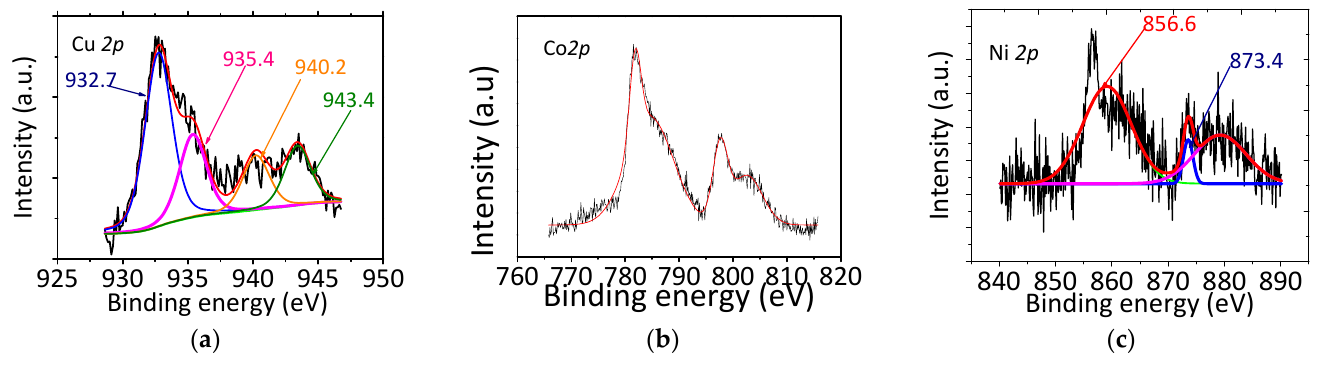
Figure 12. XPS spectra of the Cu 2 p , Ni 2 p , and Co 2 p core levels, respectively, for ( a ) CuCa1H after the 5th cycle, ( b ) CoCu1H after the 3rd cycle, and ( c ) NiCa1H after 6 h of reaction. Reaction conditions: 75 mg of catalyst, glycerol to acetic acid molar ratio of 0.25 and reaction temperature of 80 °C . As found elsewhere [51], the high energy satellite of the doublet Cu 2 p 1/2 is usually overlapped by Ca LMM Auger resonance peaks, however, although the X-ray Cu LMM ger lines are very noisy, which proved that relevant presence of Cu + species on CuCa1H.